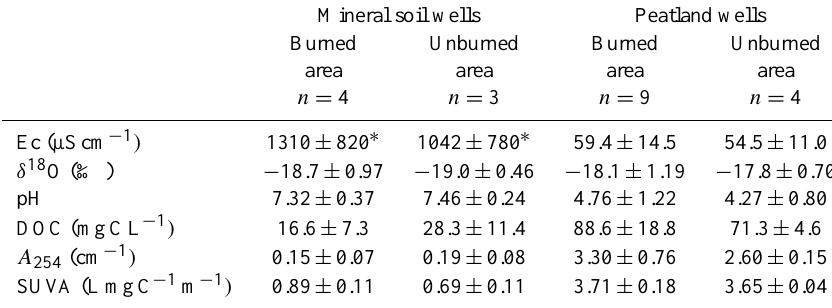
Table 3. Water chemistry of terrestrial DOC sources. Averages ± 1 standard deviation. Mineral soil wells Peatland wells